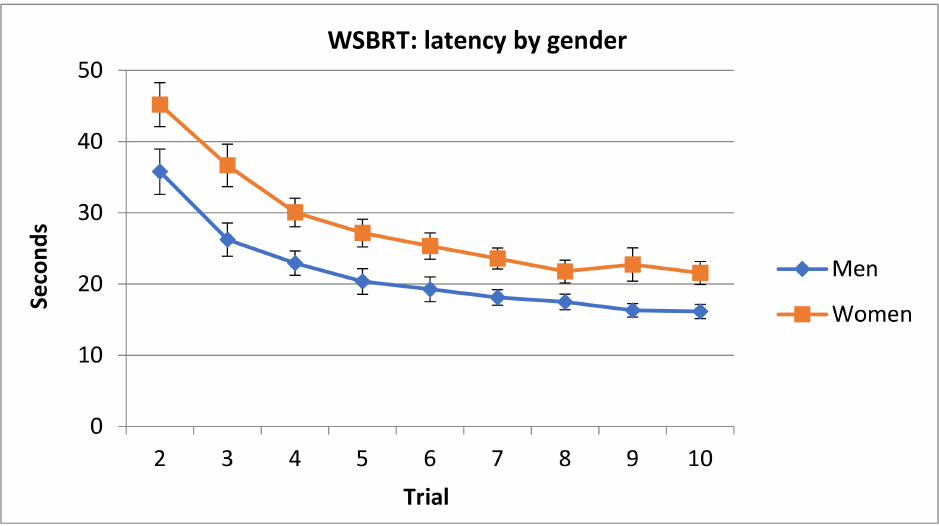
Figure 6. Time spent by men and women in the WSBRT. Note that trial 1 was removed from analysis since performance was at random. (Mean ±